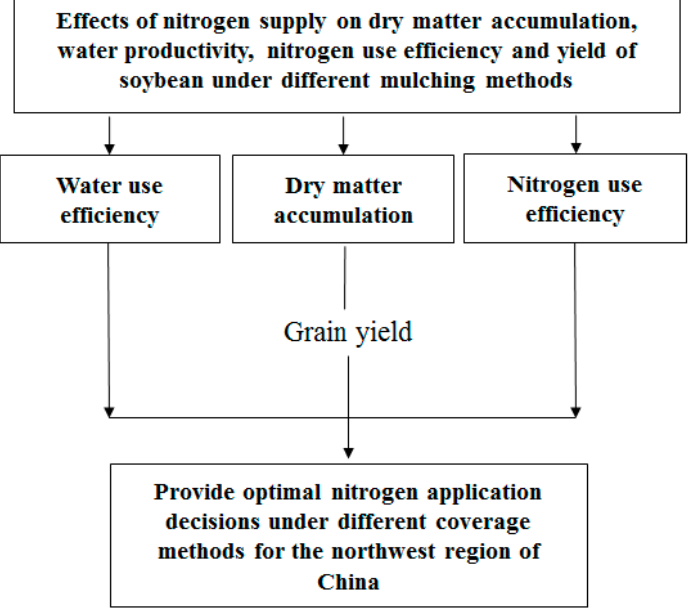
Figure 3. Diagrams of architectures used in the experiments.